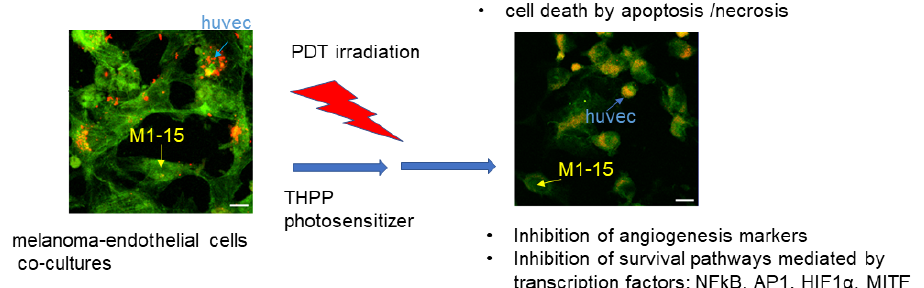
Figure 10. Diagram of the main PDT mechanisms in the current study. Melanoma (WM35, human, M1-15, human, B16-F10, murine) and endothelial cells (HUVEC, human) co-cultures were established, then subjected to PDT mediated by THPP as photosensitizer. The main mechanisms of cell killing were apoptosis and necrosis. PDT efficacy was enhanced by the inhibition of the pro-survival mechanisms, mediated by transcription factors such as NFkB, AP1, HIF1 α , and MITF.